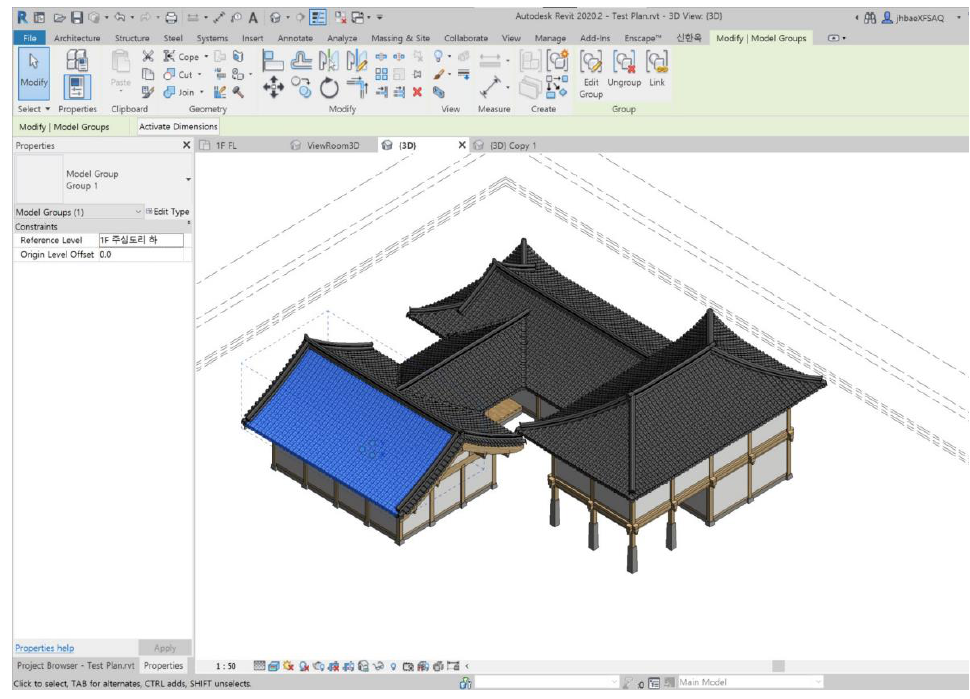
Figure 11. 3D modeling of Hanok using an automatic design program [45].